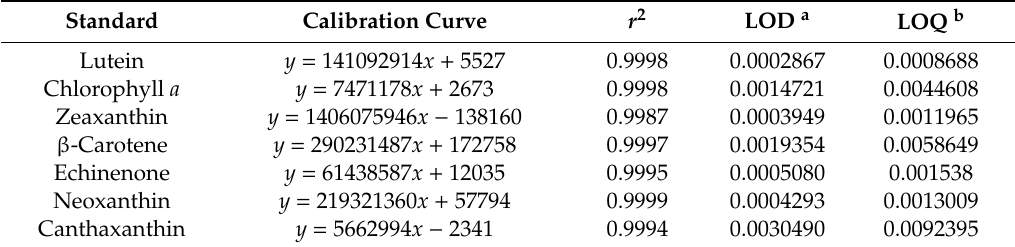
Table 2. Calibration curves of carotenoid standards and chlorophyll a